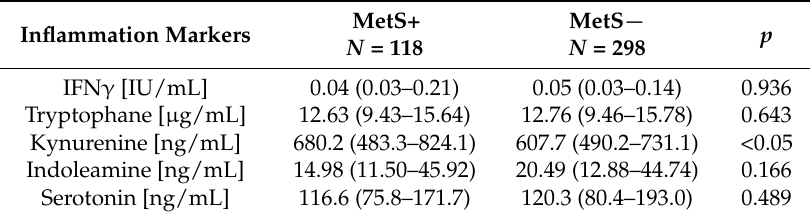
Table 1. Characteristics of interferon-gamma (IFN γ )-inducible inflammatory cascade with regard to metabolic syndrome (MetS).